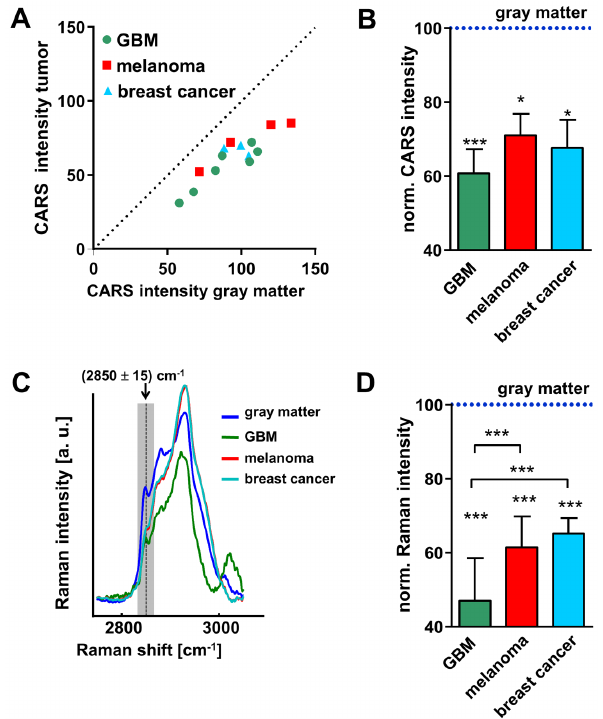
Figure 4. Quantification of the CARS signal intensity and lipid- related Raman band intensity. A : Dot plot showing the CARS signal intensity in normal gray matter vs. the intensity of the CARS signal in the neoplastic tissue for each sample. B : CARS signal intensities of tumors normalized to the respective intensities in gray matter. C : Average Raman spectra of normal gray matter, glioblastoma, melano- ma, and breast cancer metastases. D : Intensity of the Raman band generated by symmetric stretching of the C-H bonds in CH 2 groups at 2850 cm 2 1 , calculated as integral in the range (2850 6 15) cm 2 1 . Values were normalized to values of gray matter. B/D : Bars represent mean 6 SD, GBM n=8; melanoma metastases n=4; breast cancer metastases n=4; * significant difference vs. gray matter: P , 0.05; *** significant difference vs. gray matter or as indicated: P , 0.001.